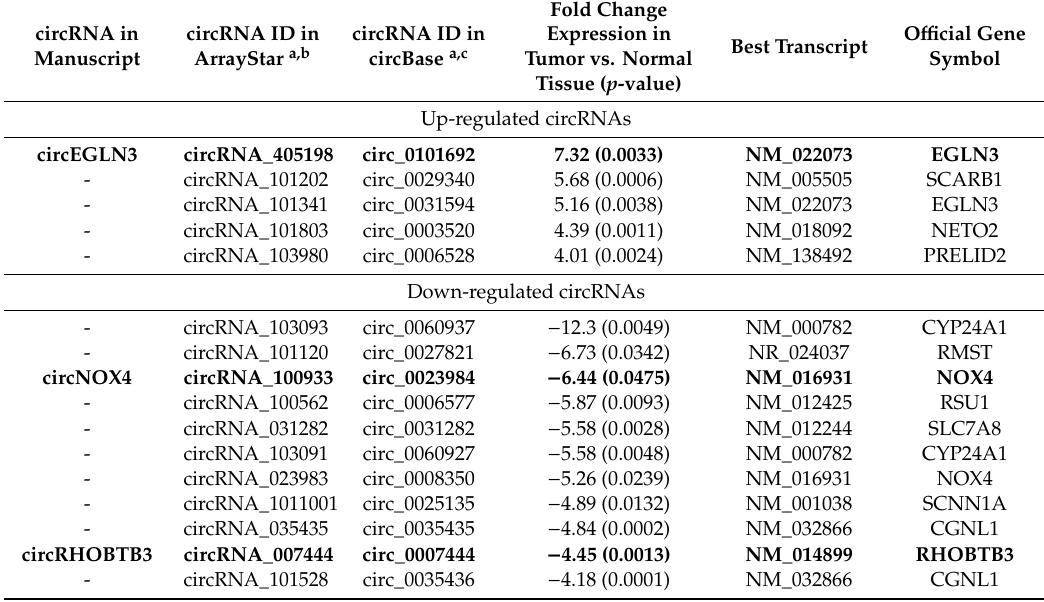
Table 2. List of circular RNAs (circRNAs) with at least a fourfold di ff erential expression between the matched malignant vs. adjacent normal tissue samples ( n = 7) in the microarray discovery study phase. The three circRNAs selected for further examination in this study are marked in bold